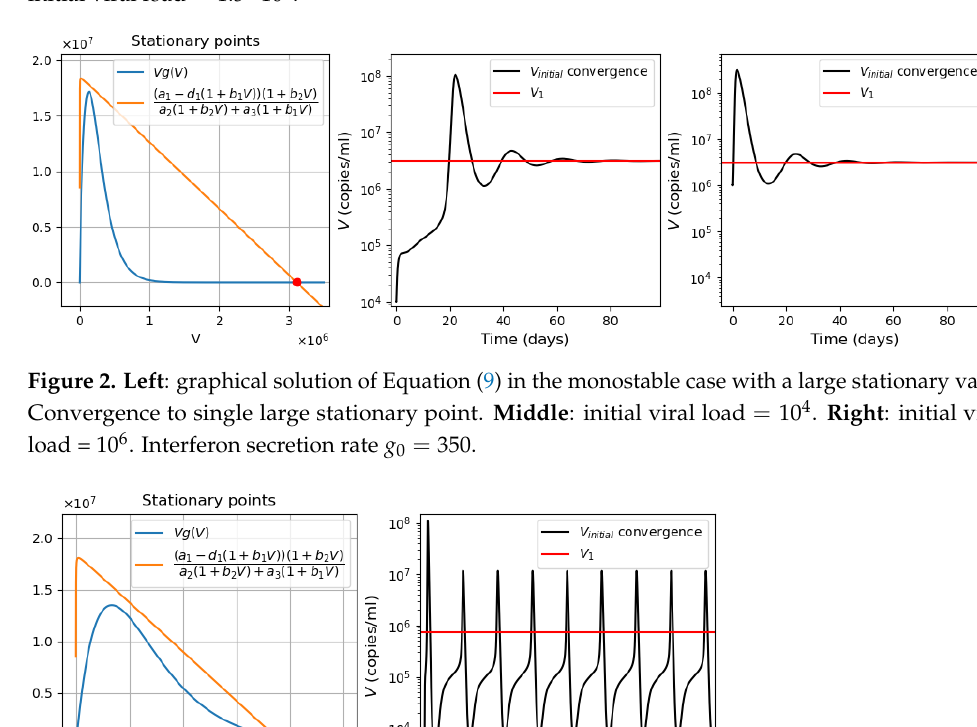
Figure 1. Left : graphical solutions of Equation (9) in the bistable case. Middle : convergence to the first stationary point, initial viral load = 1.48 · 10 5 . Right : convergence to the third stationary point, initial viral load = 1.5 · 10 5 .